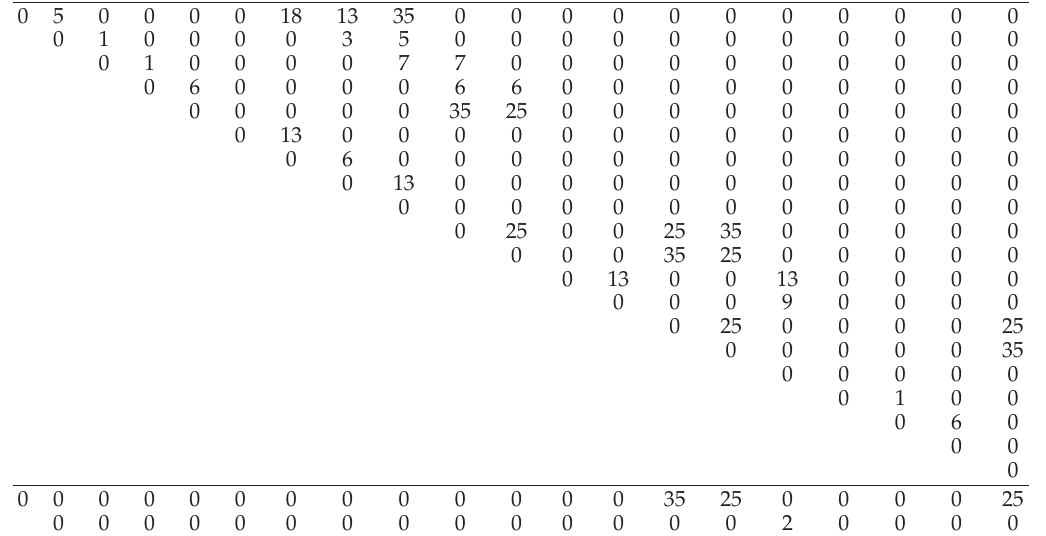
Table 1: Sample data weight matrix (cid:3) W 1 ,W 3 ,W 4 (cid:4)